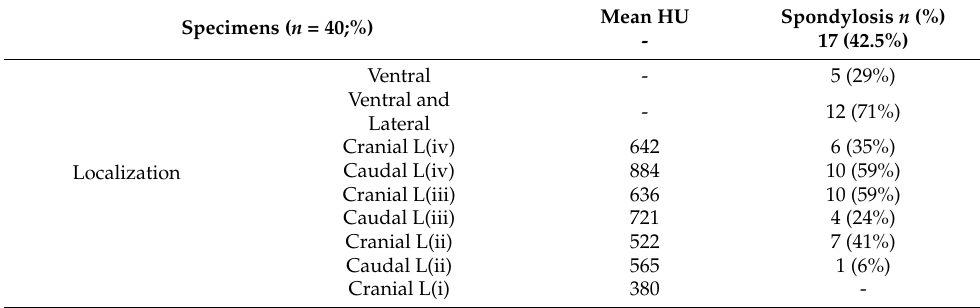
Table 5. Mean bone density (Hounsfield Units) (mean HU) of the cranial and caudal endplate of the vertebral bodies from the cranial L(iv) to the cranial L(i) endplate; number ( n ), prevalence (%), and localization of lumbar spondylosis for 40 specimens which underwent post-mortem computed tomographic evaluation of the caudal lumbar region. L(iv): fourth to the most caudal lumbar vertebra; L(iii): third to the most caudal lumbar vertebra; L(ii): second to the most caudal lumbar vertebra; L(i): the most caudal lumbar vertebra. Mean HU Spondylosis n (%) Specimens ( n = 40;%) - 17 (42.5%)